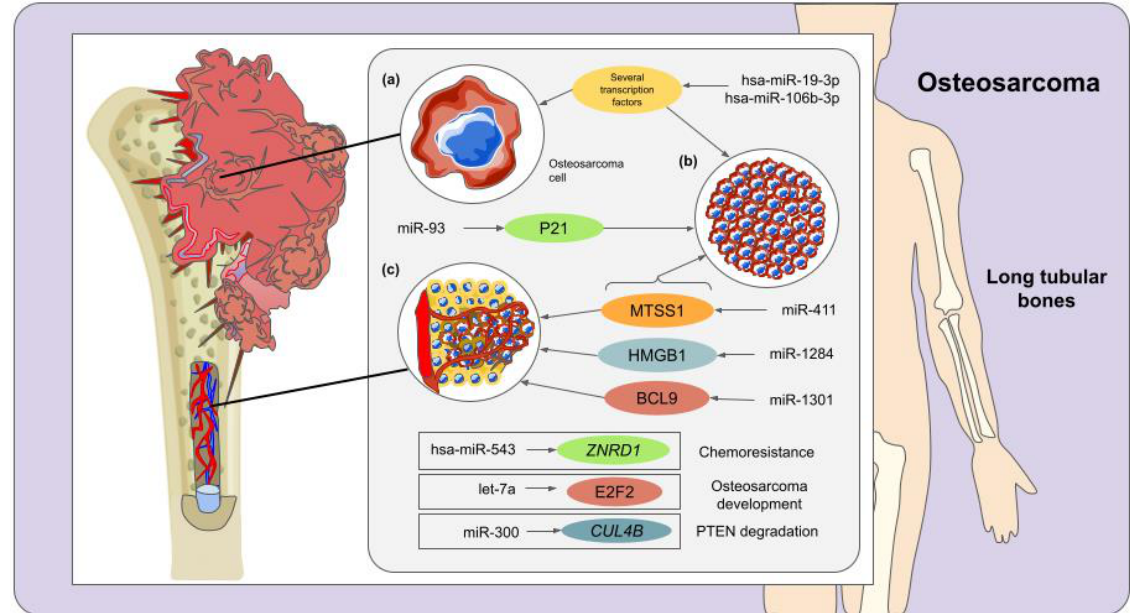
Figure 3. Crucial miRNAs involved in osteosarcoma development and progression. Carcinogenesis ( a ), cell proliferation ( b ), and cell invasion and migration ( c ) have been identified as the most illustrative biological implications for miRNAs in osteosarcoma disease. Some of these miRNAs exhibit more than one role in the main stages of osteosarcoma pathology. Furthermore, these regulatory molecules enclose a remarkable potential as biomarkers for